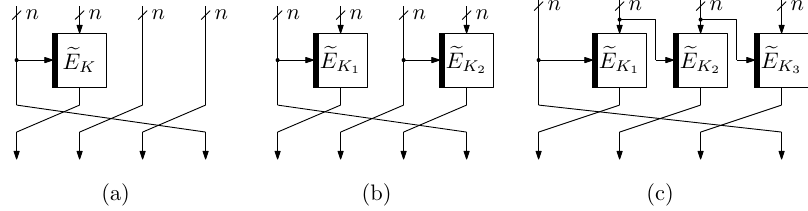
Figure 2: Round functions of TBC-based GFSs. (a) Type-1 (b) Type-2 (c) Type-3